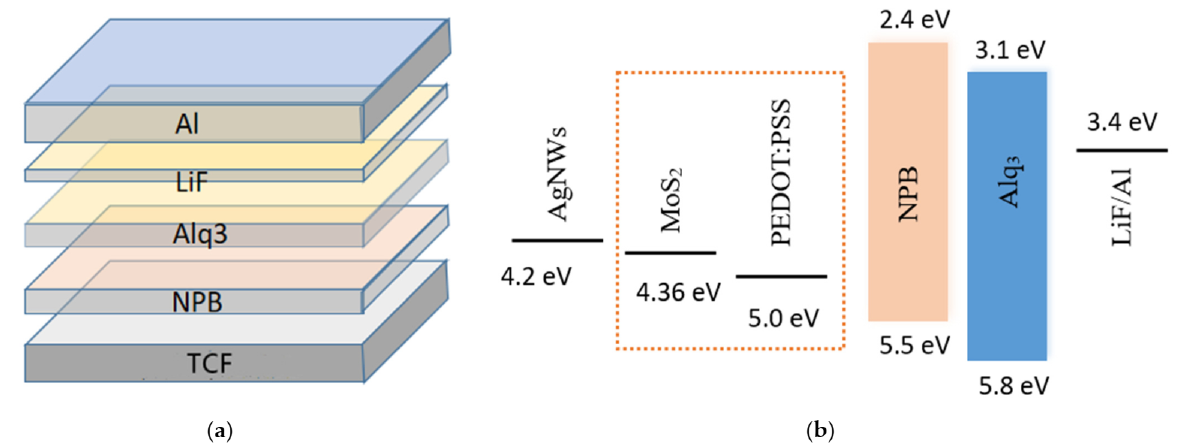
Figure 8. Schematic diagram of OLED device structure and energy level: ( a ) structure diagram; ( b ) energy level diagram.